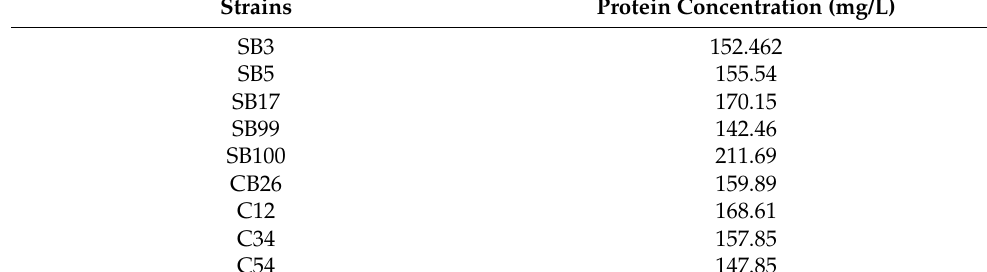
Table 6. Quantification of proteins produced by LAB isolated from meat products.